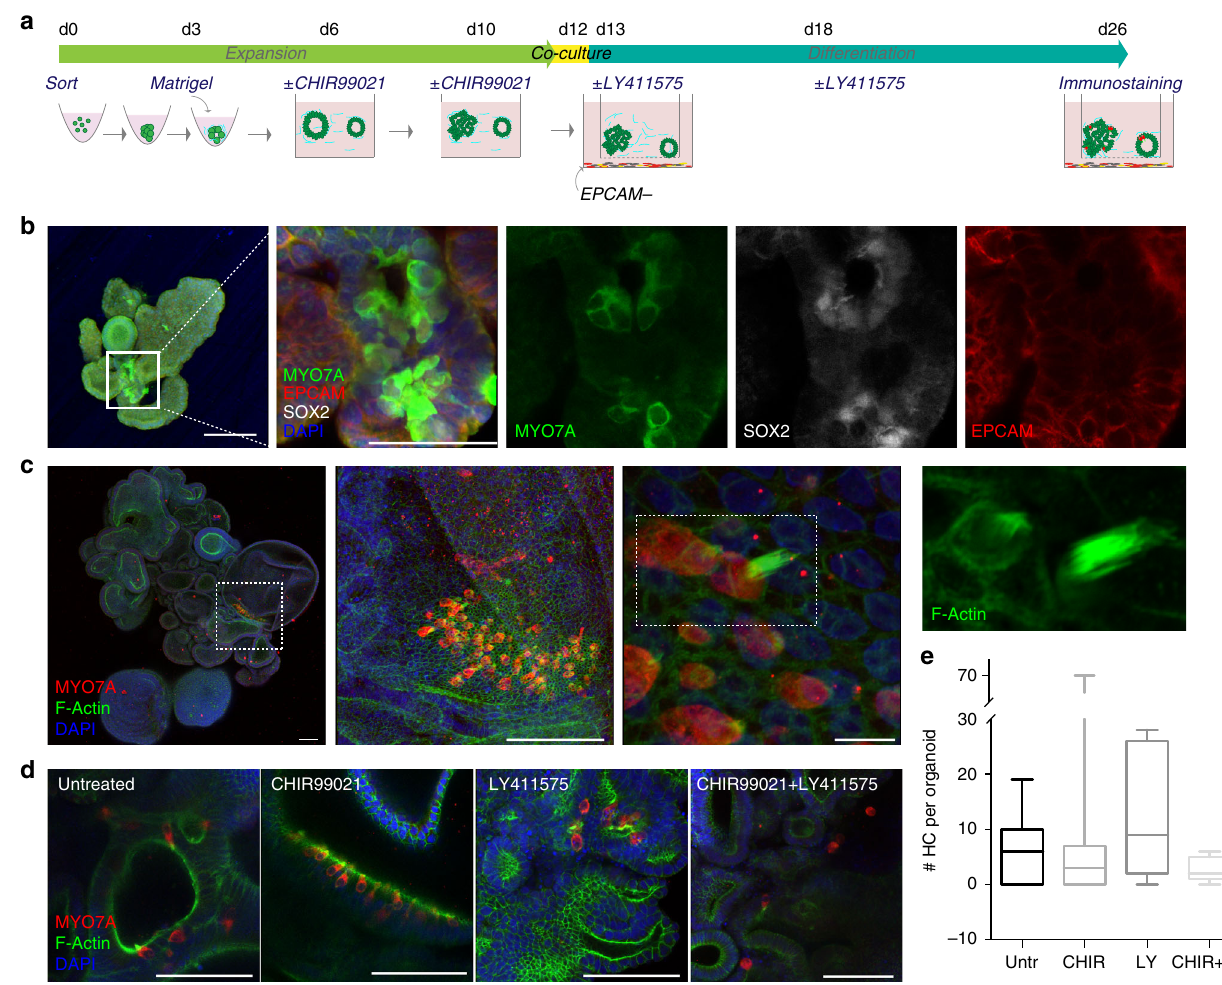
Fig. 5 Organoids from EPCAM + cells generate hair cell-like cells. a Schematic drawing of the experimental procedure. EPCAM + organoids were expanded for 2 weeks with or without CHIR99021, then co-cultured with EPCAM − cells in transwell inserts. EPCAM − cells were derived in parallel from the same sample. The medium was supplemented twice with LY411575 or with vehicle during the 2-week differentiation period as indicated. b Organoid derived from sample E1229 and immunostained at the end of the differentiation protocol for MYO7A, SOX2, and EPCAM. Scale bar = 100 μ m. The merged high magni fi cation image is a confocal projection; the single channels are shown as individual confocal sections. Scale bar = 50 μ m. c Organoid derived from sample E1246 ( + CHIR99021) and immunostained at the end of the differentiation protocol for MYO7A. F-actin bundle was labeled with phalloidin. Consecutive magni fi cations are shown. Scale bars = 100 μ m (left and middle), and 10 μ m (right). d Images of MYO7A positive areas in organoids untreated/treated with CHIR99021 during the expansion phase and untreated/treated with LY411575 during the differentiation phase, as indicated. Scale bar = 100 μ m. e Quanti fi cation of the number of hair cells-like cells (HC) per organoid at the end of the differentiation protocol for the different culture conditions as indicated. Three to four organoids per condition per sample were analyzed. Five human fetal samples of ≈ week 11 were used for this experiment (E1245, E1246, E1229, E1248, E1253). Box plots showing sample distribution and median. Whiskers represent minimum and maximum